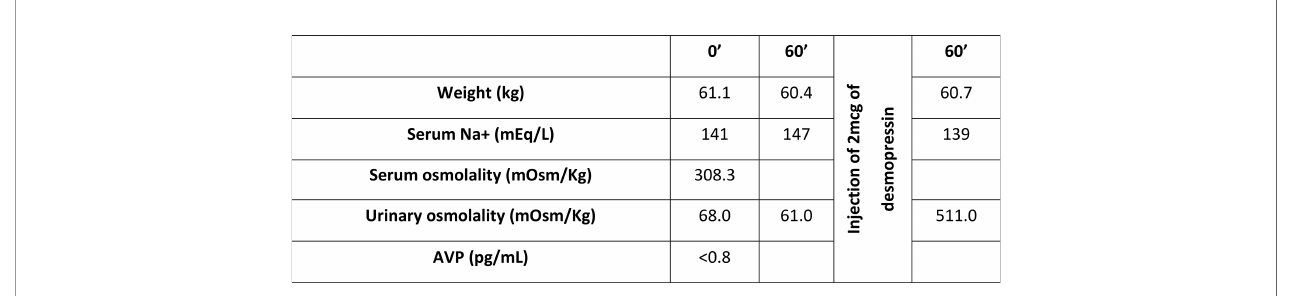
FIGURE 1 | Water deprivation test results.